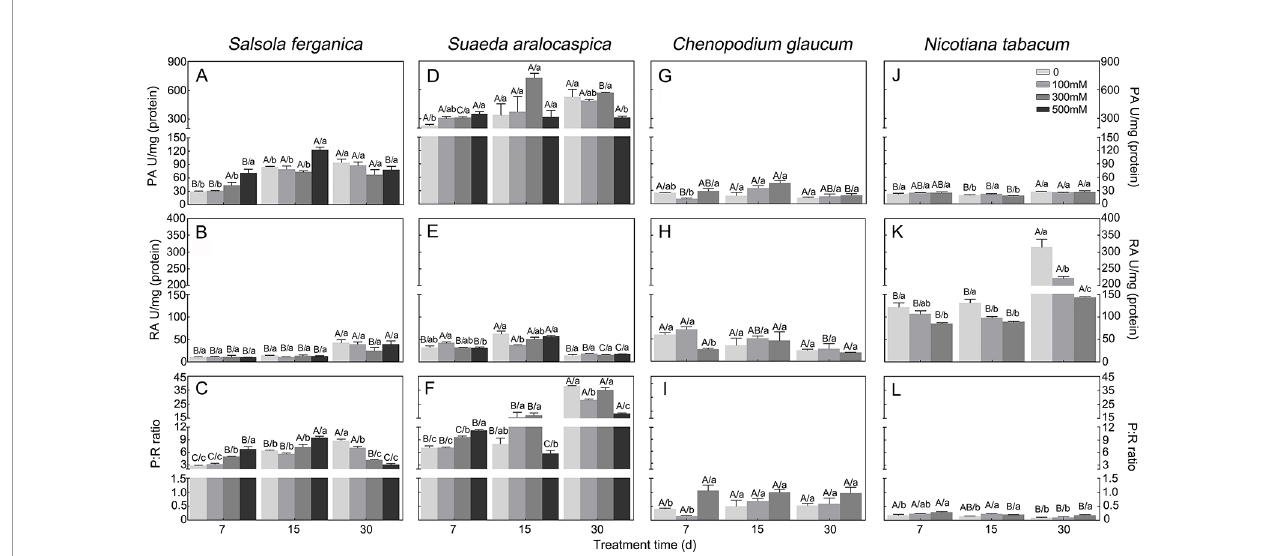
FIGURE 5 | Changes of PEPC and RUBPC activity and its ratio in S. ferganica , S. aralocaspica , C. glaucum , and N. tabacum under NaCl treatment at different developmental stages. (A – C) S. ferganica ; (D – F) S. aralocaspica ; (G – I) C. glaucum ; (J – L) N . tabacum ; (A, D, G, J) PEPC activity; (B, E, H, K) RUBPC activity; (C, F, I, L) Ratio of PEPC: RUBPC. PA, PEPC activity; RA, RUBPC activity; P: R, PEPC activity: RUBPC activity; 7, 15, 30: Days of seedling after emergence. Different lowercase letters above columns indicate signi fi cant differences ( P < 0.05 or 0.01) among different NaCl concentrations at the same developmental stage; different uppercase letters above columns indicate signi fi cant difference ( P < 0.05 or 0.01) among different developmental stages at the same NaCl concentration. Values are means ± SE of four